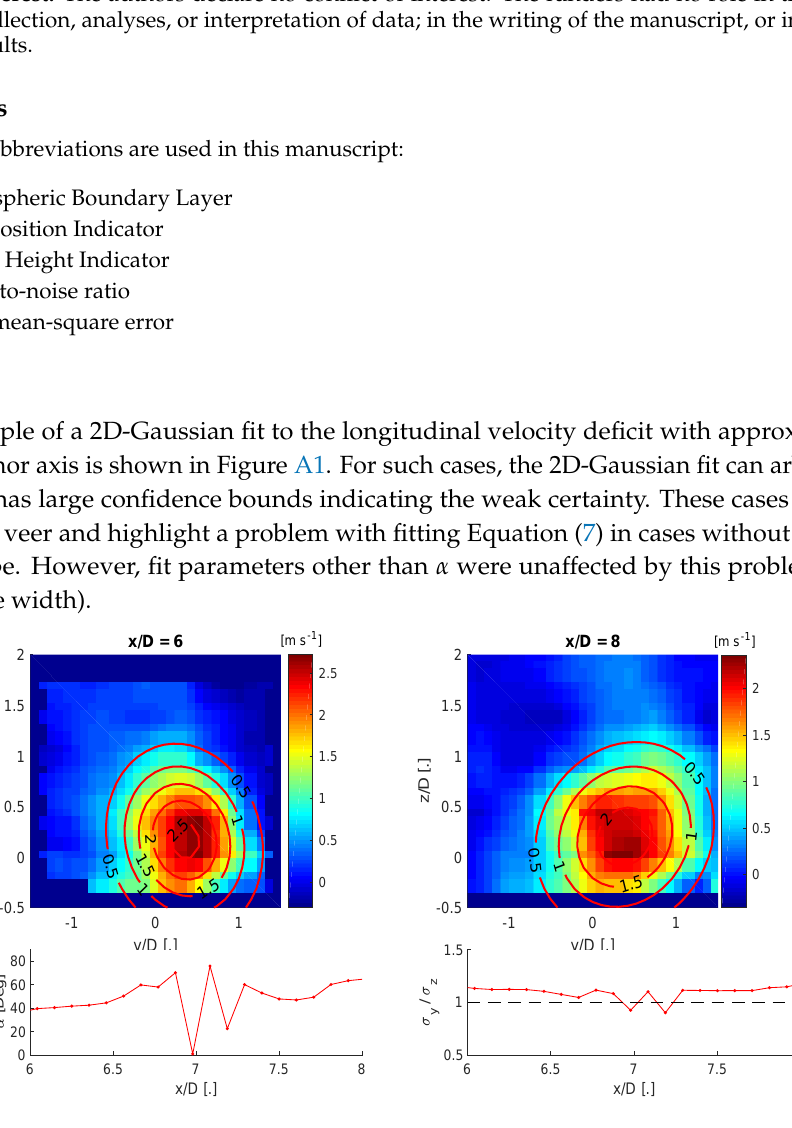
Figure A1. Example of a 2D-Gaussian fit to spanwise cross-sections of the velocity deficit rotating by 90 ◦ for a nearly circular wake (8 September 2017—2200 UTC). The top two panels show cross-sections of the longitudinal velocity deficit at x / D = 6 and x / D = 8 together with contour lines of the 2D-Gaussian fit. The bottom row shows the tilt angle of the wake ( α ) on the left and the ratio of the ellipse axes σ y / σ z on the